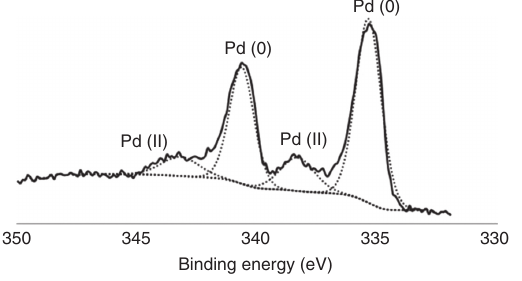
Figure 2: XPS spectra of Pd/G catalyst. _______ Raw data; ……….. Fitted